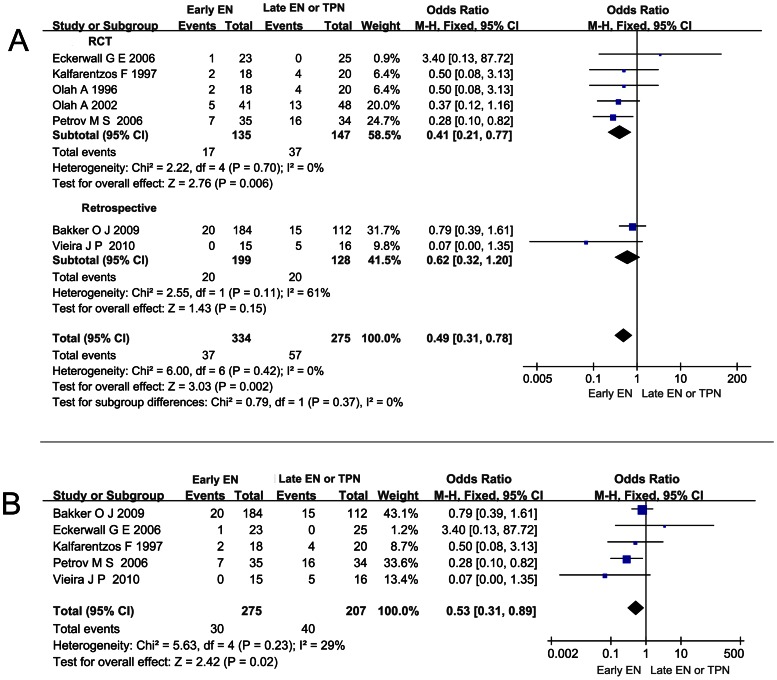
Effect of early EN on pancreatic infection complications of AP.(A) Forest plot (Fixed-effect model) showing the effect of early EN on pancreatic infection complications of AP and the sensitivity analysis subtotaling the plots by RCTs vs. retrospective studies. (B) Forest plot (Fixed-effect model) of a selection of five articles recruiting patients of pSAP or SAP.